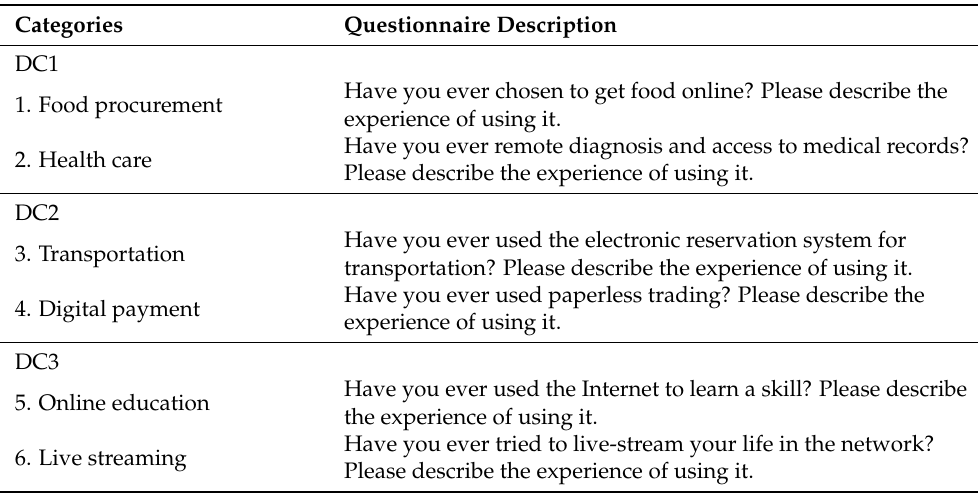
Table 5. The open-ended questionnaire